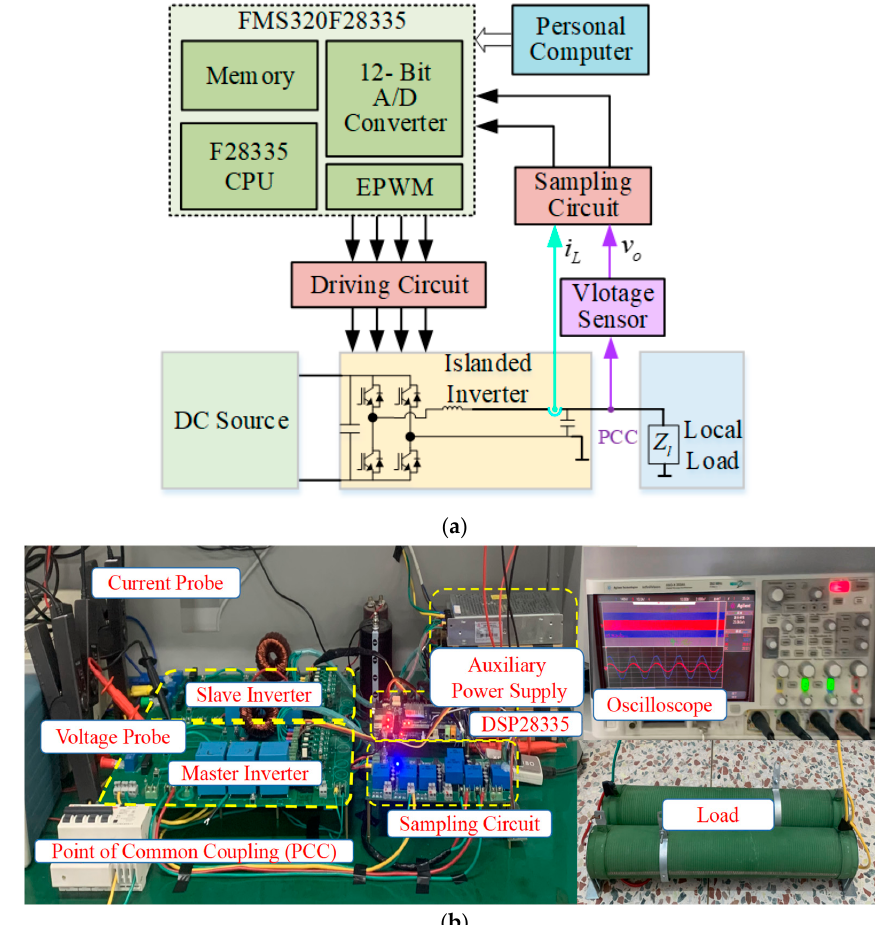
Figure 9. Prototype of islanded inverter: ( a ) Block diagram of hardware; ( b )